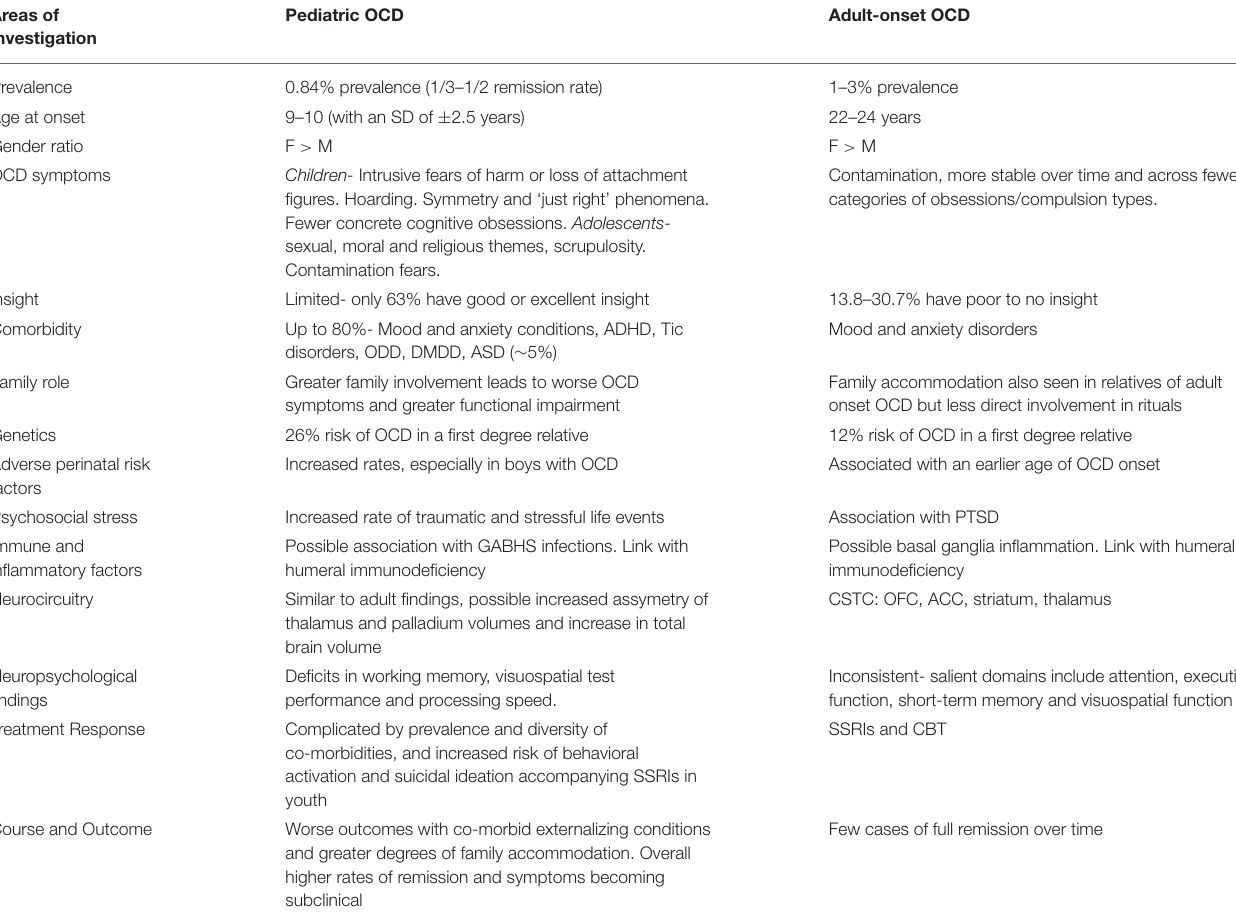
TABLE 2 | Comparison of pediatric and adult-onset OCD. Areas of